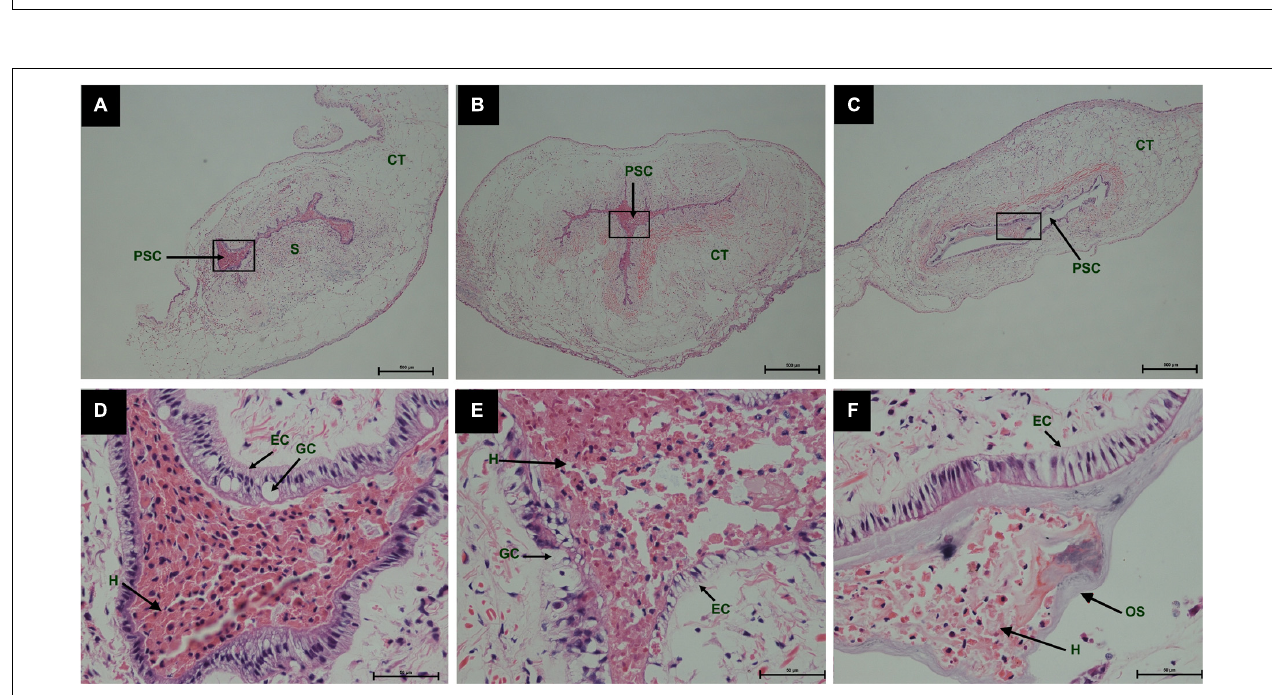
FIGURE 2 | Histology of pearl sac development in Hyriopsis cumingii on days 8, 10 and 12 after grafting by Haematoxylin-Eosin staining. (A–C) are overview of developmental pear sac in the pallial mantle of host mussel on days 8, 10, and 12, respectively. The black boxes indicate the areas shown at higher magnification. (D–F) are the high magnification views of partial area of pearl sac in panels ( A–C) , respectively. The abbreviations indicate S, saibo, PSC, pearl sac cavity, H, hemocyte, CT, connective tissue, EC, epithelial cell on pearl sac, GC, gland cell on pearl sac. Scale bars are 500 µ m in panels (A–C) , 100 µ m in panels ( E–G) .